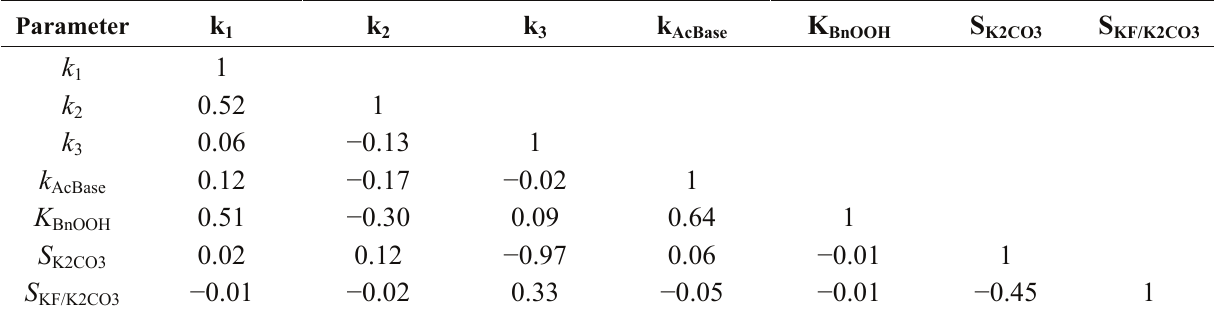
Table 3. Correlation matrix between all the parameters estimated using the optimized kinetic